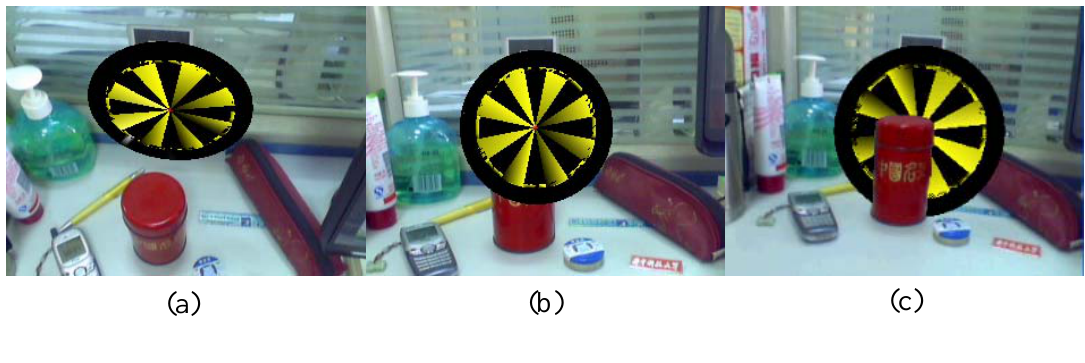
Figure 1. Occlusion problem in augmented